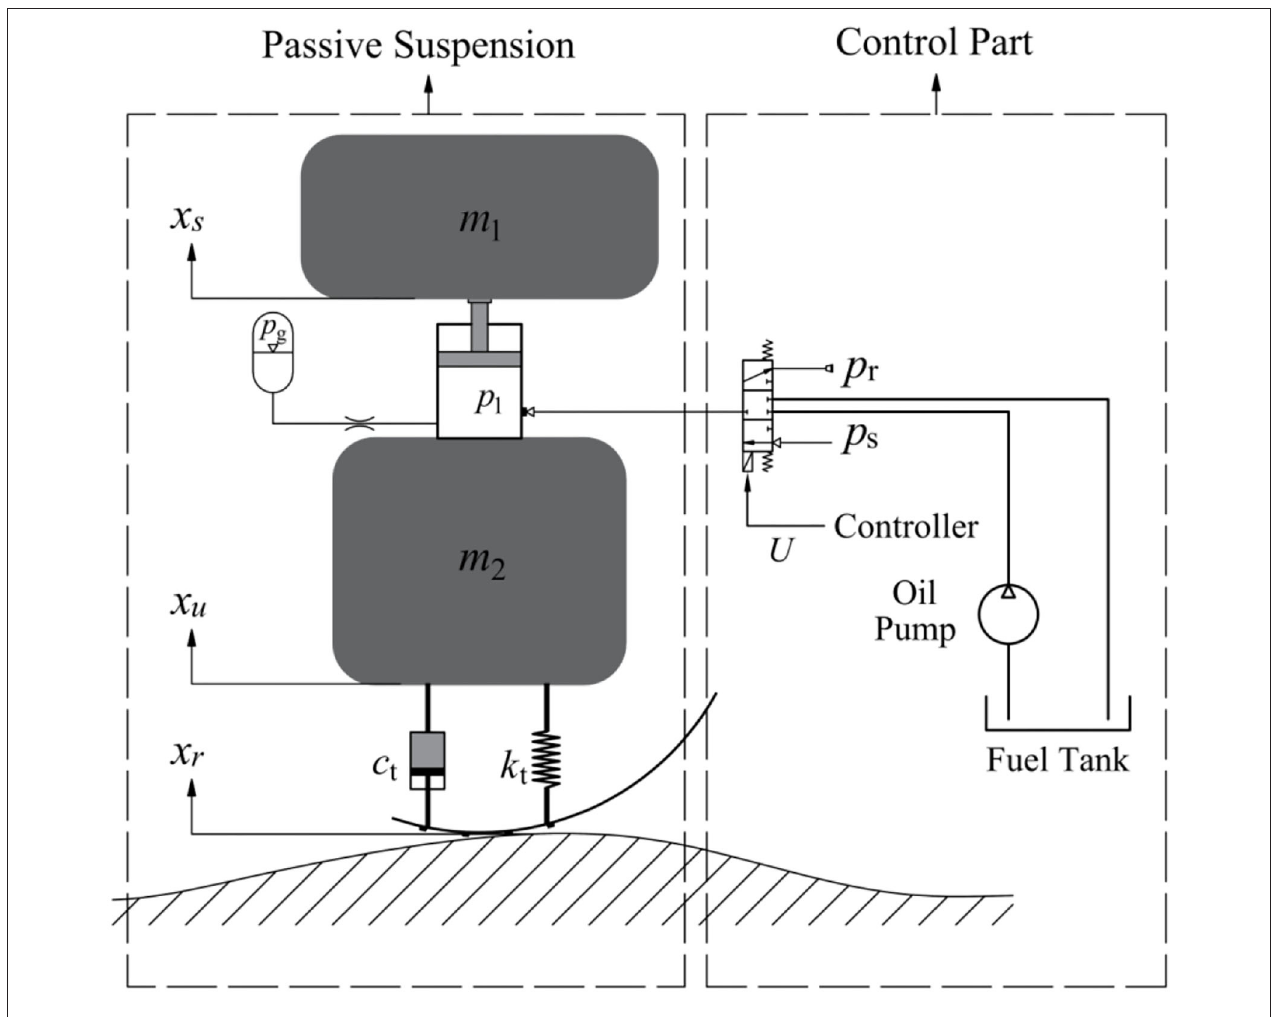
FIGURE 1 | Dynamic model of active hydro-pneumatic